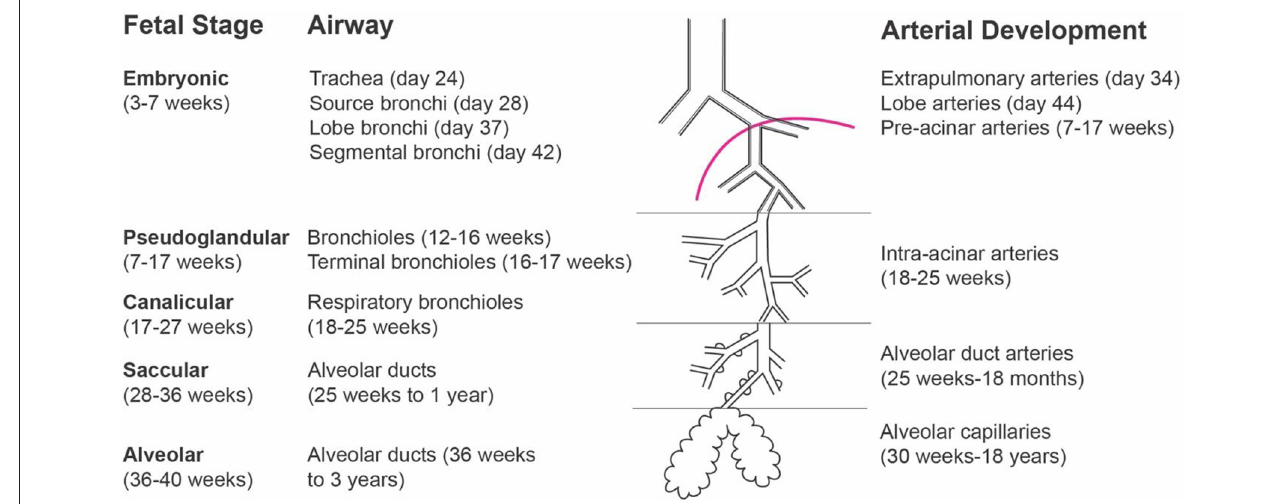
FIGURE 3 | Stages of fetal lung